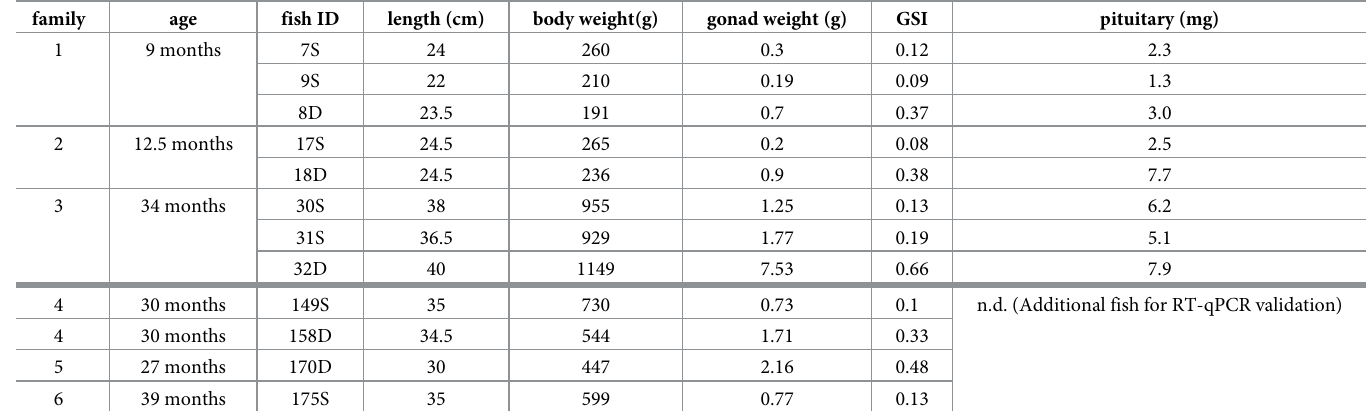
Table 4. Measurements of experimental